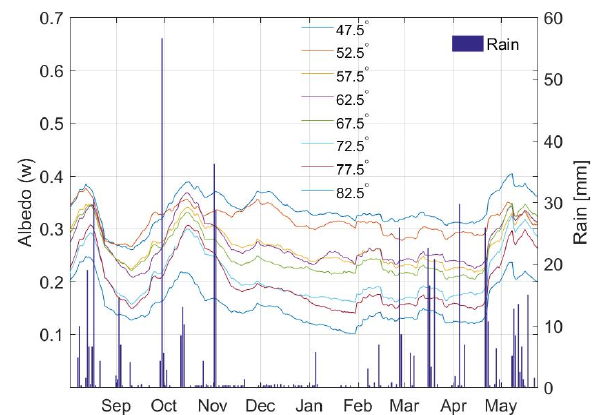
Figure 15. Evolution of the estimated albedo ( ω ) versus time at different elevation angles.